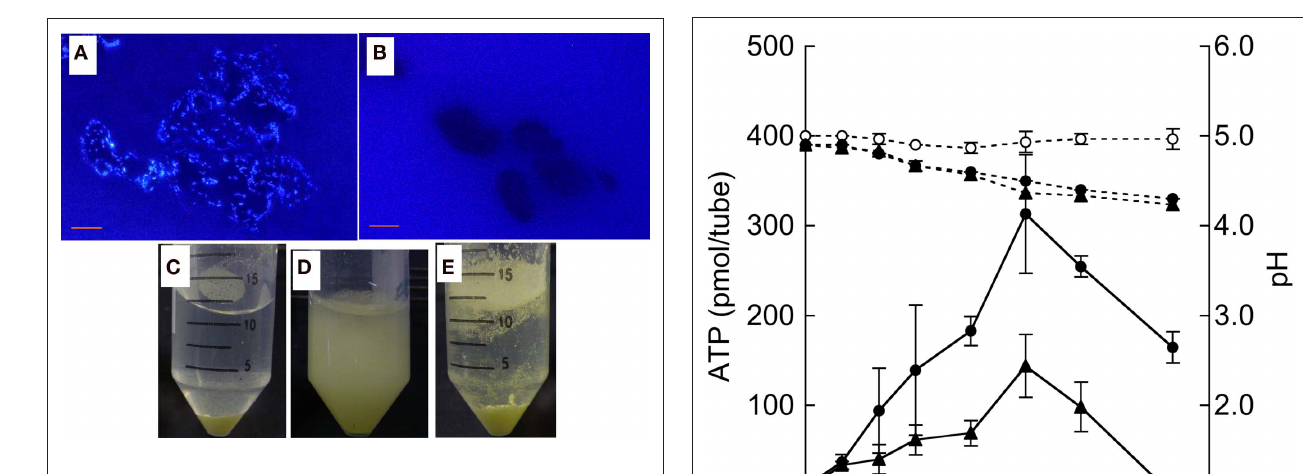
FiguRe 2 | growth of strain THi503 with S 0 . (A,B) Fluorescence microphotographs of WS5 liquid medium culture with S 0 after 9 day. (A) with strain THI503 and (B) without strain THI503. Bar indicates 10 μm. (C,D,e) S 0 in WS5 media after 7 day of incubation. (C,D) With or (e) without strain THI503. Cultures were allowed to stand for 5 min (C) , followed by brief shaking (D) . In the absence of strain THI503, some S 0 remained floating on the surface